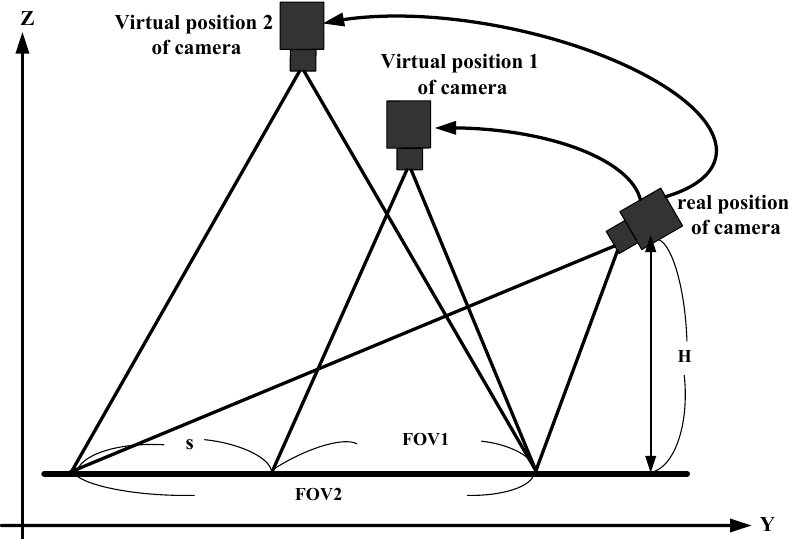
Figure 3. Related positions of the camera in TVTM that view from the Y-Z